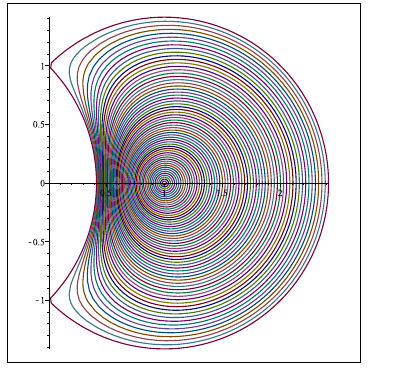
Figure 1. The image of D under ψ ( z ) =